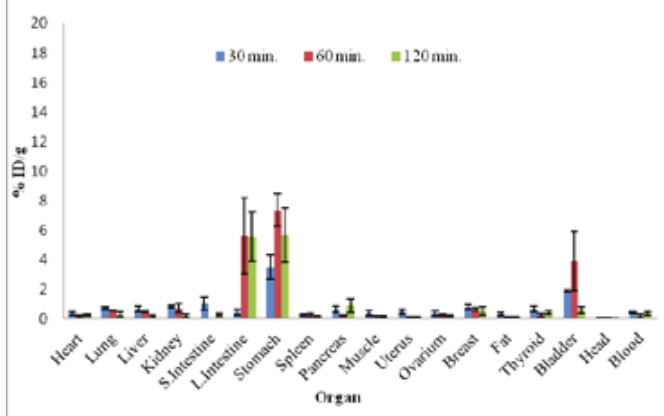
FIGURE 5 - %ID/g of 131 I-Peak 7 for female Wistar albino rats.